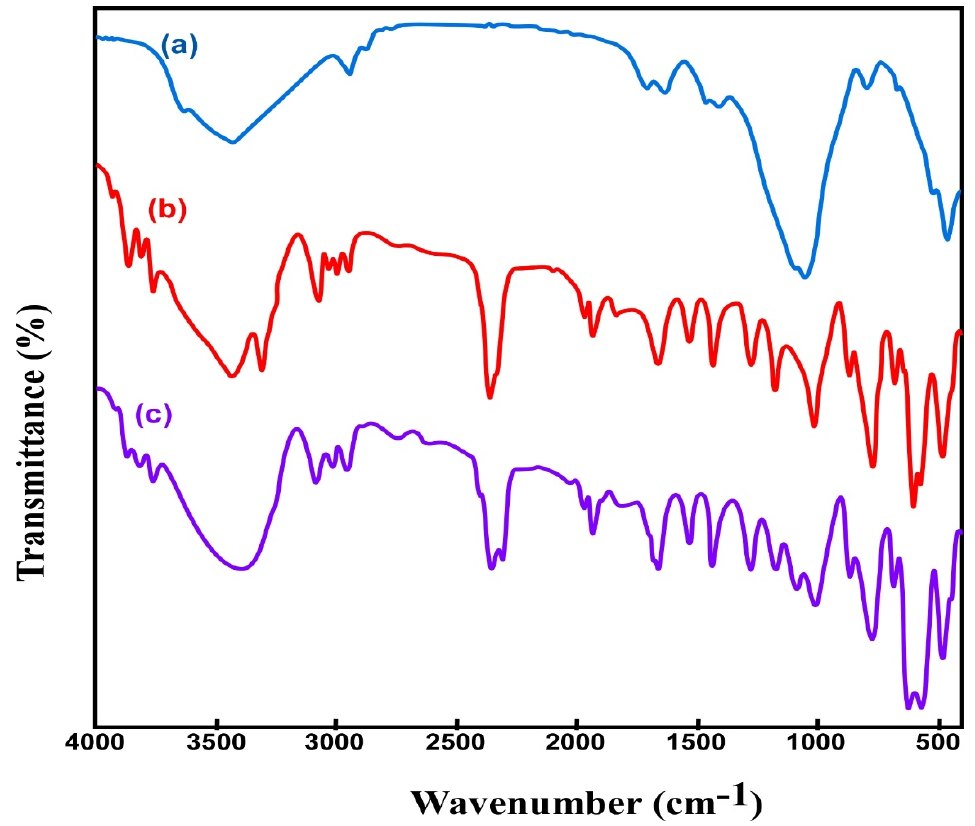
Figure 6. FTIR spectra of ( a ) treated bleaching clay, ( b ) AHIBC, and ( c ) Y(III) loaded on AHIBC surface.